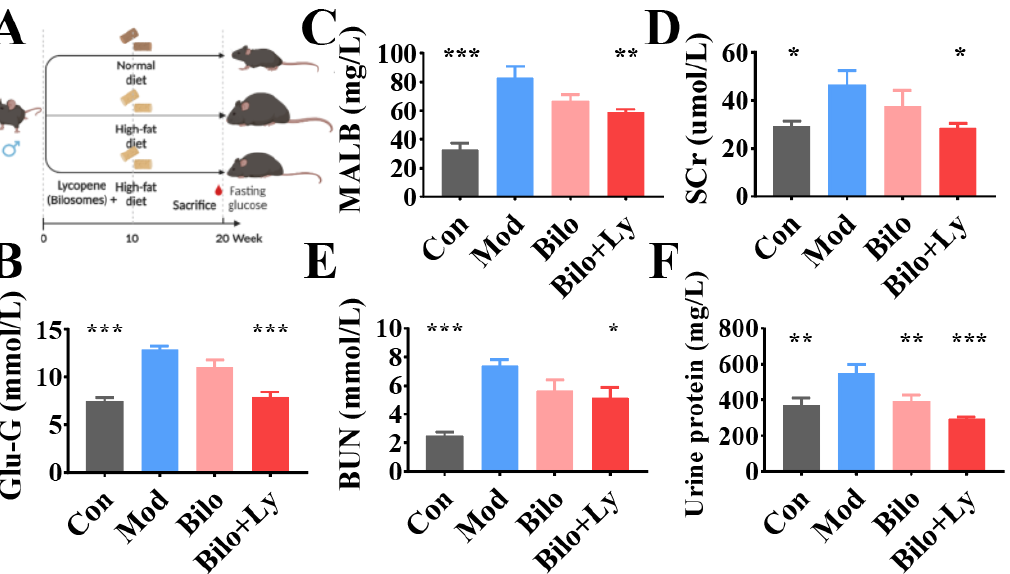
Figure 1. The effect of lycopene on the biochemical analysis of mouse serum. Animal experiment flow chart ( A ). Fasting blood glucose levels in mice ( B ). MALB content in serum ( C ). SCr content in serum ( D ). BUN content in serum ( E ). Urine protein content in serum ( F ). Signs of significance of difference between Mod group and other groups: * p < 0.05, ** p < 0.01, *** p < 0.001.